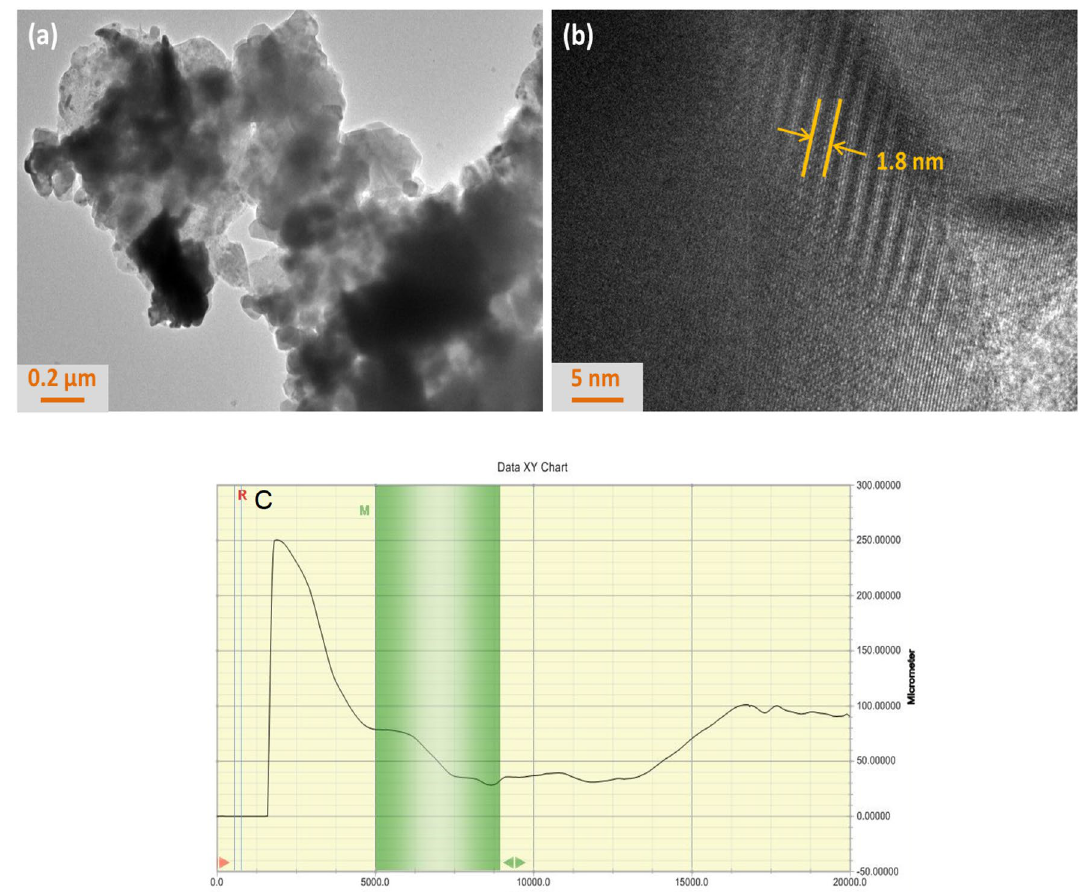
Figure 3. Morphology of HRTEM images of Nb 2 C MXene ( a ) HRTEM image of Nb 2 C MXene at low magnification ( b ) HRTEM image of Nb 2 C MXene at low magnification and ( c ) surface profiler measurement.